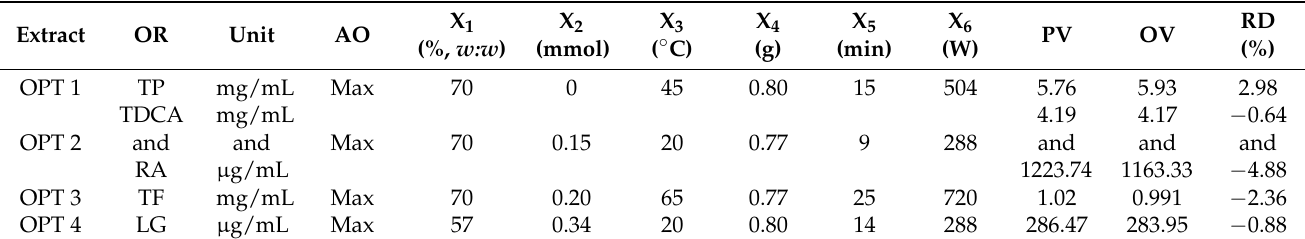
Table 4. Predicted and observed response values for the extracts prepared using calculated optimal